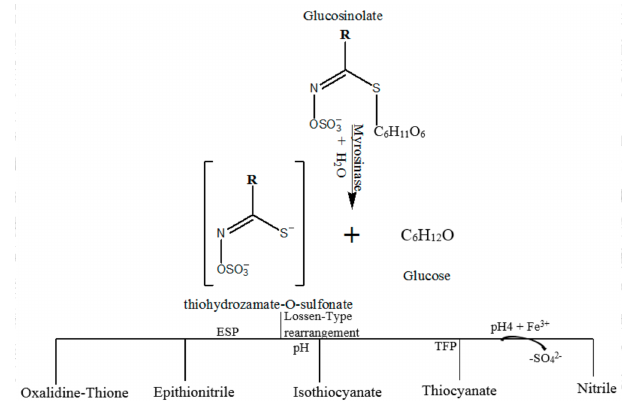
Figure 1. General model of glucosinolates’ hydrolysis by myrosinase to form various specific compounds. ESP and TFP represent epithiospecifier protein and thiocyanate forming protein respectively. The figure was adapted from Fuentes et al.